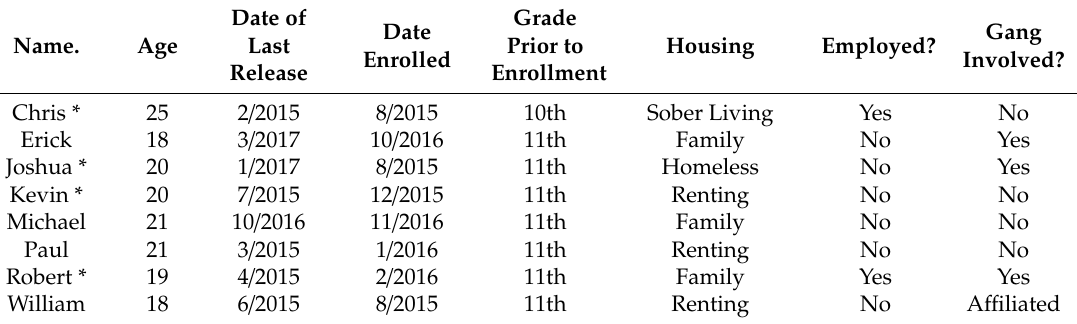
Table 2. Formerly incarcerated young Black men participant